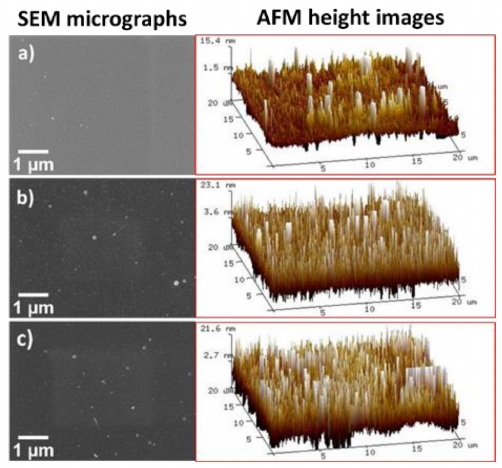
Figure 1. SEM ( left ) and AFM 3D height images ( right ) on ITO substrates: ( a ) after ultrasonication